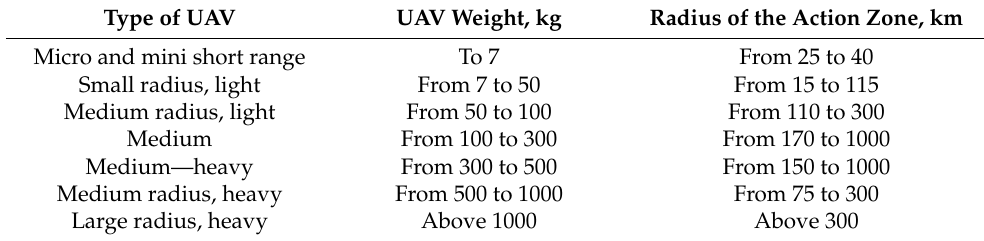
Table 3. Classification of UAVs